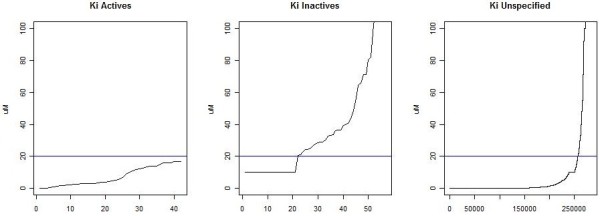
Defining activity based on a Ki cut-off. Experimental Ki values of active, inactive and unspecified compounds found in ChEMBL.